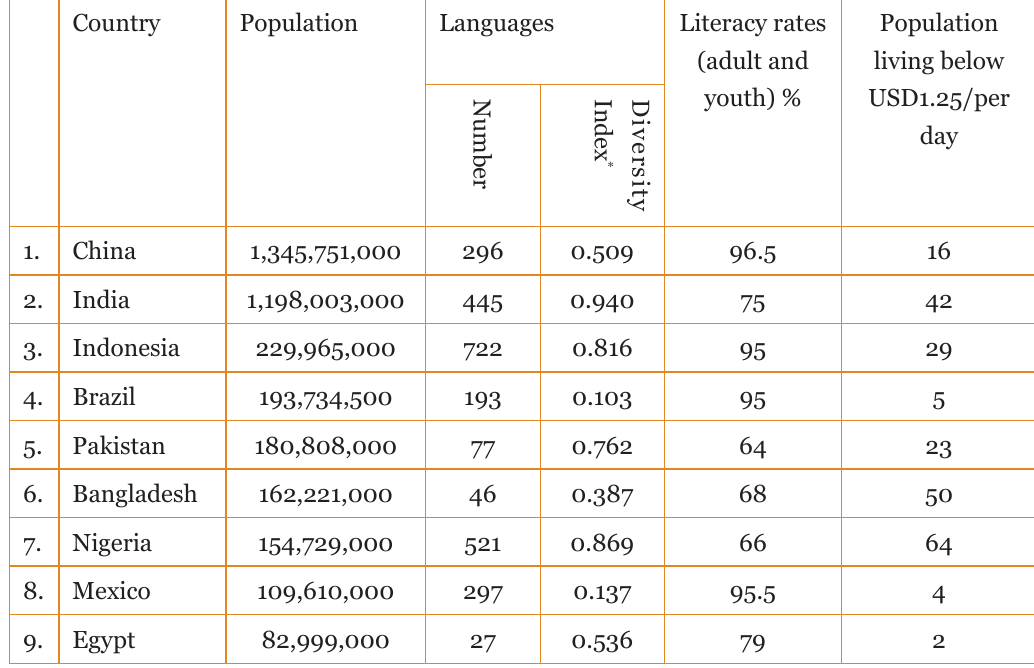
E-9 Countries’ Statistics Country Population Languages Literacy rates